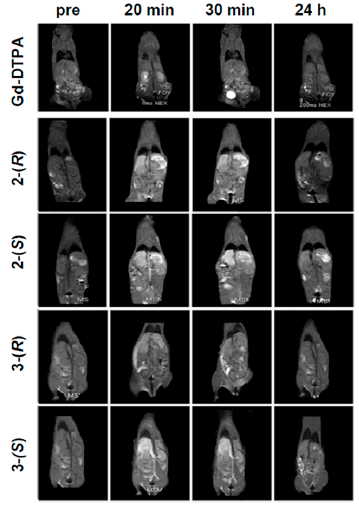
Figure 4. T 1 -weighted MR images of mice after intravenous injection of Gd-DTPA, 2 -( R ), 2 -( S ), 3 -( R ) and 3- ( S ) (0.10 mmol Gd/kg).